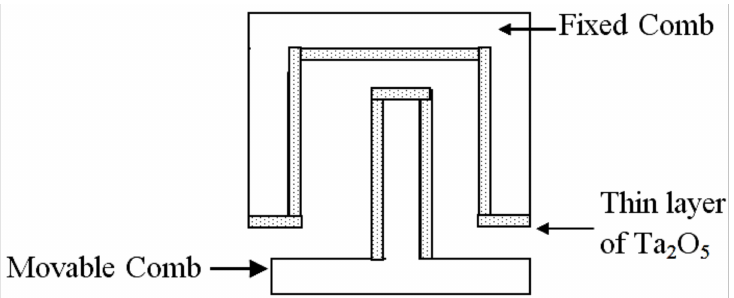
Figure 4. Demonstration of the converter fingers with the deposition of Ta 2 O 5